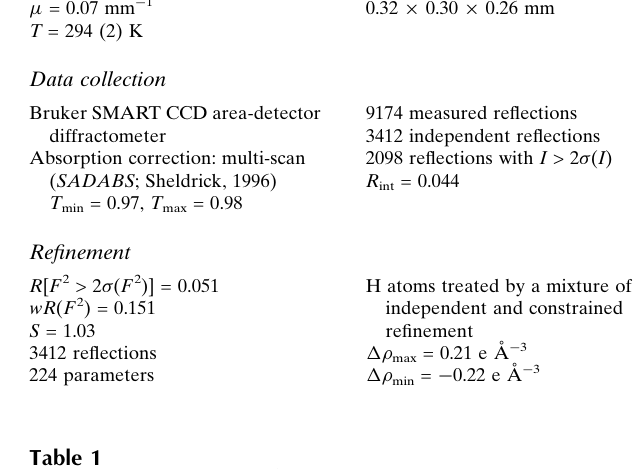
Hydrogen-bond geometry (A˚ , (cid:2)